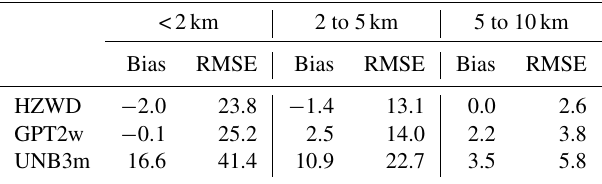
Table 2. Error statistics for the three models compared to the 2015 ECMWF data